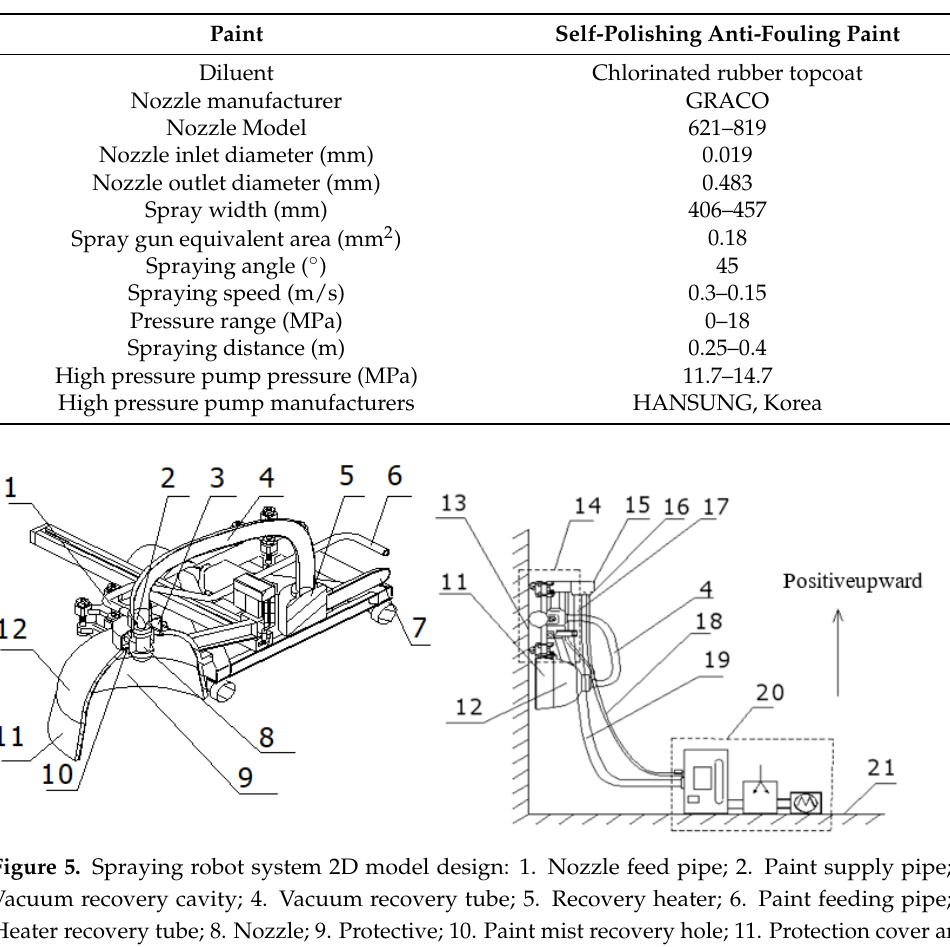
( b ) Figure 6. Nozzle inner chamber exit section structure. ( a ): Structure diagram; ( b ): Physical map. The cavity flow paint component is laminar and turbulent flow, and turbulent flow is chosen for the study in this paper. Let its flow critical Reynolds number Re be 8000– 10,000, the paint property density ρ be 1320 kg/m 3 , and the dynamic viscosity γ be 0.275 kg/(m.s). The paint needs to satisfy the following equations in the flow process. 2.2.1. Continuity Equation The continuity equation means that the difference between the mass of the fluid flow- ing into and out of the control body through the control surface should be equal to the increment of the fluid mass inside the control body. Derive the integral equation of the fluid continuity equation in the form shown in Equation (1):